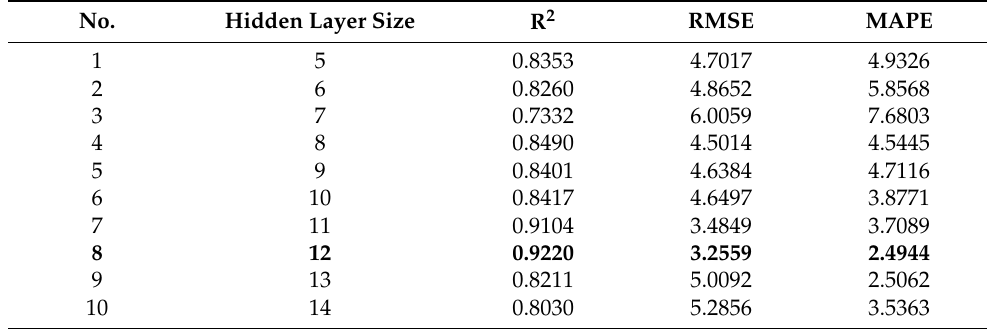
Table A1. Effect of the hidden layer size on WT-Rrs combined model. The No.8 test in bold shows the optimal hidden layer